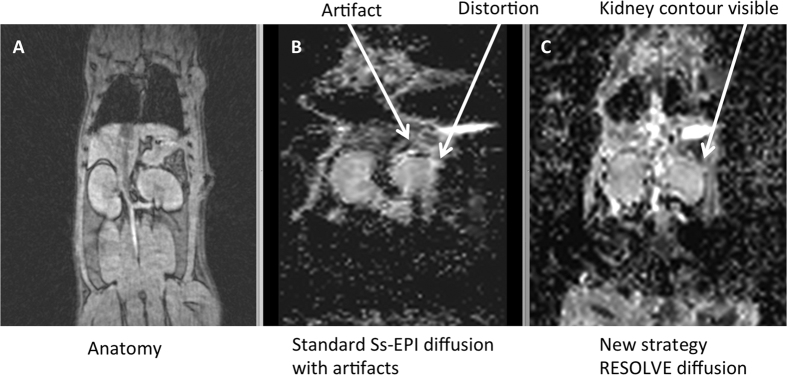
Comparison between single-shot (ss-EPI) and RESOLVE DWI MR sequences in a
small animal.Both DWI images were compared to GRE anatomical MR images (A).
Standard ss-EPI MR sequences showed severe distortion at the kidney edges
(B). In 14% of kidneys, for the ss-EPI images, the parenchyma
completely disappeared due to distortions. RESOLVE MR sequences (C)
considerably reduced artifact, enabling therefore analysis.